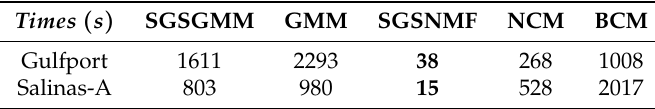
Table 8. Efficiency comparison for the real hyperspectral